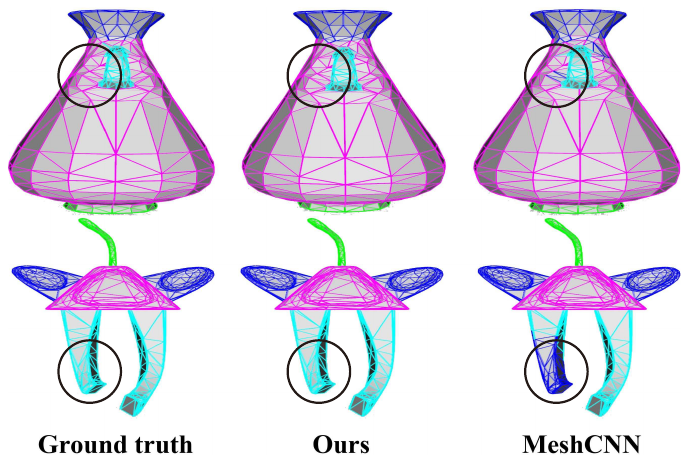
Figure 7. Comparison of qualitative segmentation results with MeshCNN [14] on a vase ( top ) and an alien ( bottom ) of the COSEG